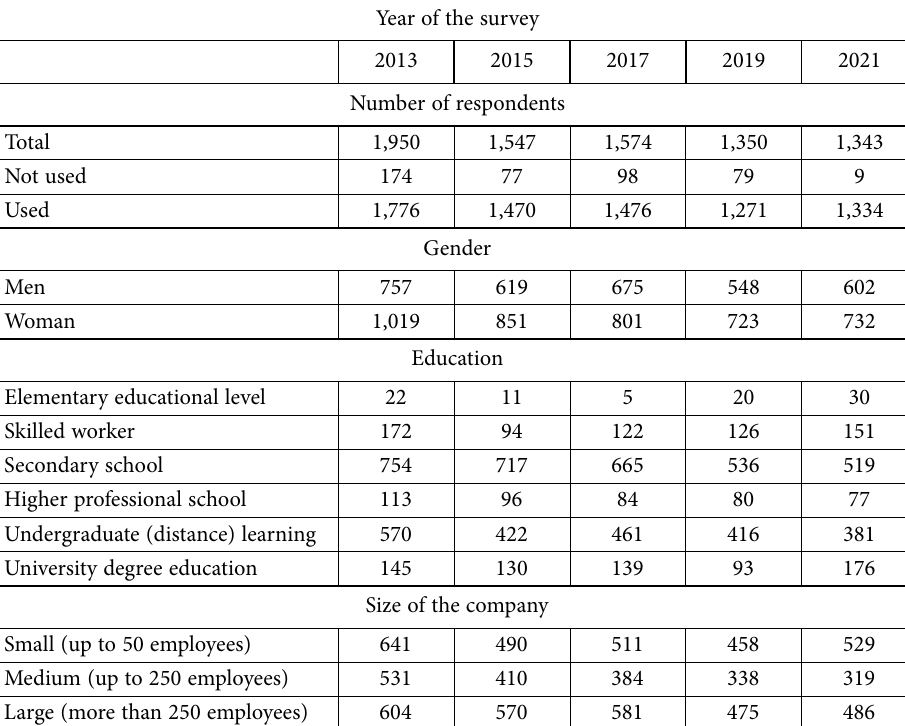
Table 1. Sample characteristics of the job satisfaction surveys conducted since 2013 (source: own